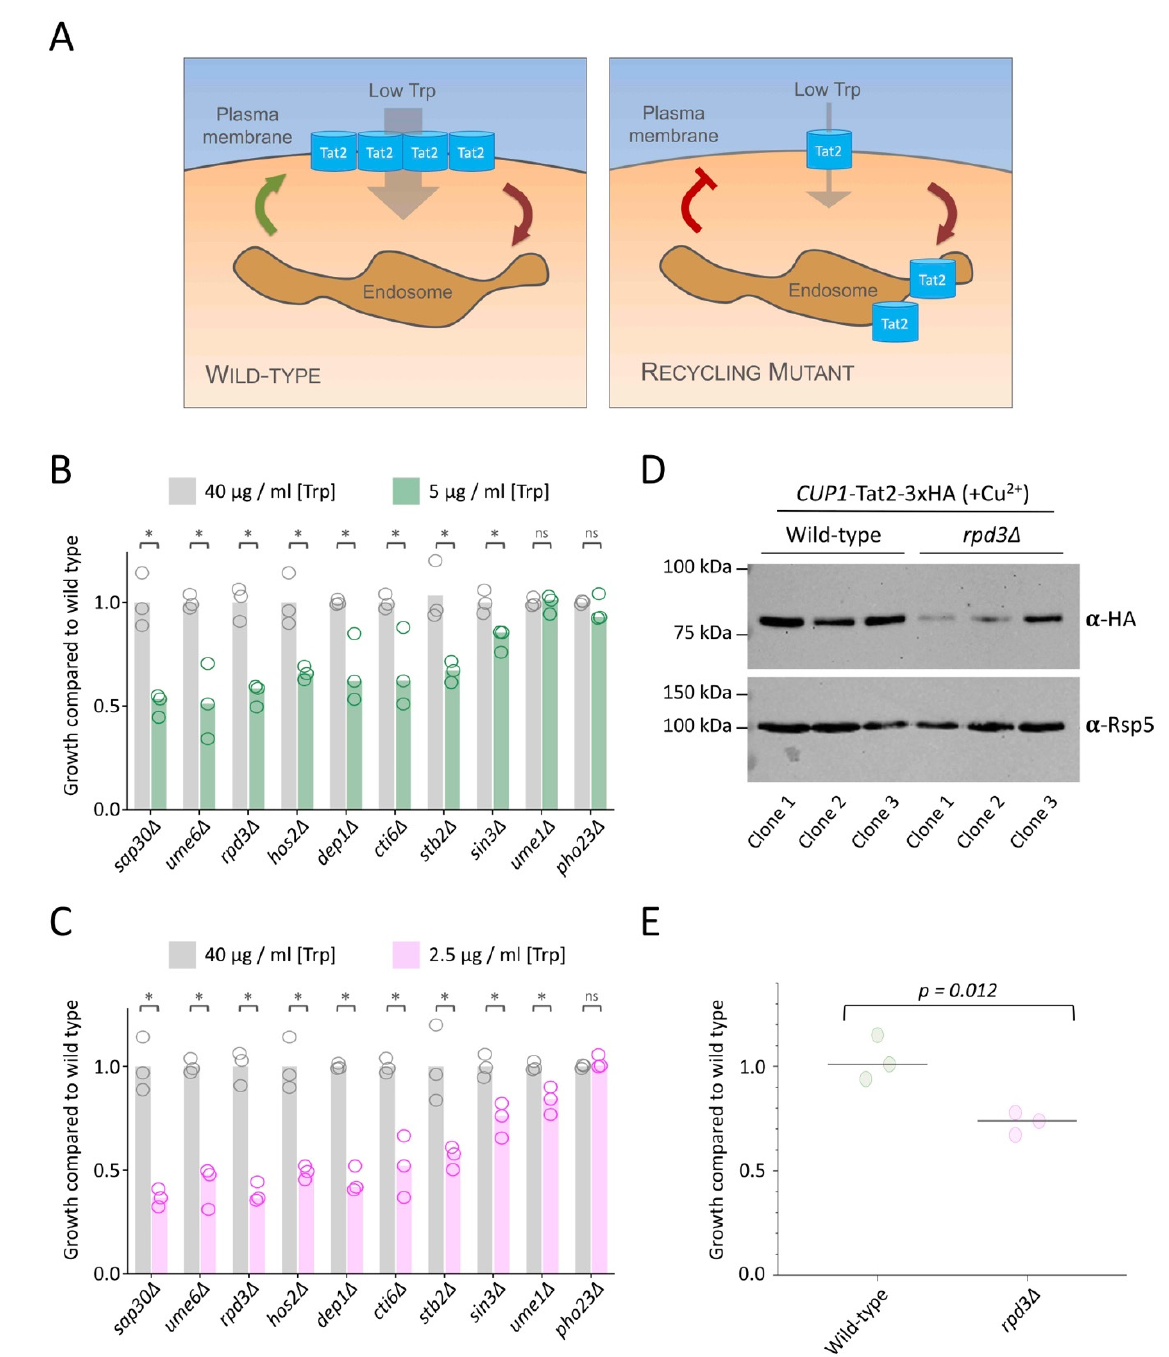
Figure 3. The Rpd3-complex is required for Tat2 recycling. ( A ) Schematic diagram showing the uptake of tryptophan via the high-affinity Tat2 permease. In tryptophan auxotroph cells grown on media containing low tryptophan concentrations, Tat2 uptake is required for efficient growth of wild-type cells (left) and Tat2 recycling defects inhibit growth (left). ( B,C ) Yeast were grown to mid-log phase and spotted out on media of replete (40 µg/mL) and limited, either 5 µg/mL in ( B ) and 2.5 µg/mL in ( C ) tryptophan concentration. Growth was measured across multiple serial dilutions and calculated as a ratio compared to wild-type cells from the same plate. Asterisks (*) used to indicate significant difference ( p < 0.03) from t -test comparisons. ( D ) Cells transformed with a Tat2-3xHA plasmid containing a copper-inducible CUP1 promoter were grown in media containing 50 µM copper chloride to mid-log phase before lysates were generated for immunoblot analysis using α -HA and α -Rsp5 antibodies. ( E ) Densitometry was used to measure the signal intensity of Tat2-HA in different clones and strains from ( D ), normalized to loading control.